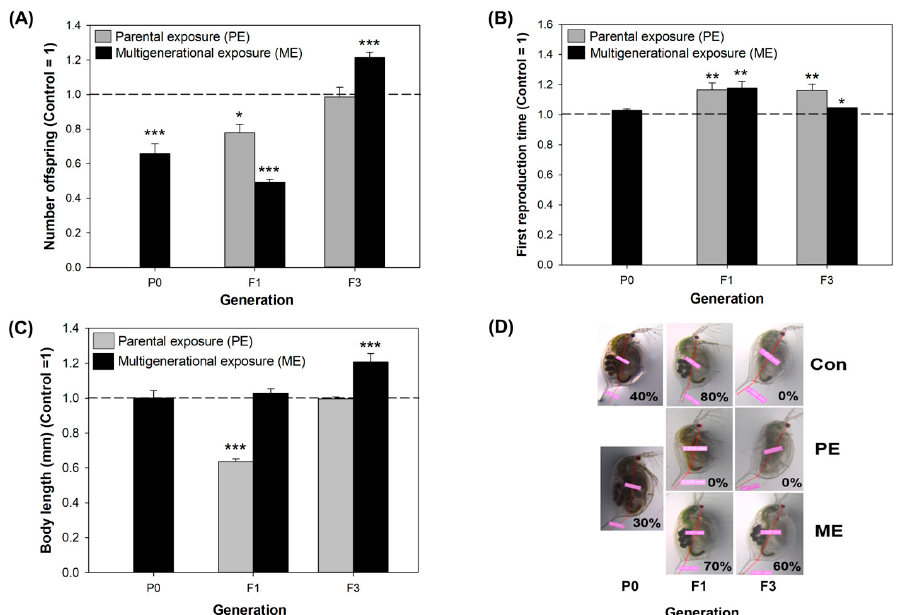
Figure 5. Phenotypic responses of daphnids to parental and multigenerational exposure to CMIT/MIT EC 20 . Data are normalized to the means of each control group and presented as nor- malized values ± SE (n = 10). Asterisks indicate significant differences between the exposure and control groups: * p < 0.05, ** p < 0.01, and *** p < 0.001. ( A ) Total number of neonates produced by adult daphnids. ( B ) First reproduction time of daphnids. ( C ) Body length of 7-day-old daphnid. ( D ) Representative images of the morphology and egg-holding rate (%) of daphnids under the two exposure scenarios. % indicates the percentage of organisms that had eggs or progenies in the brood